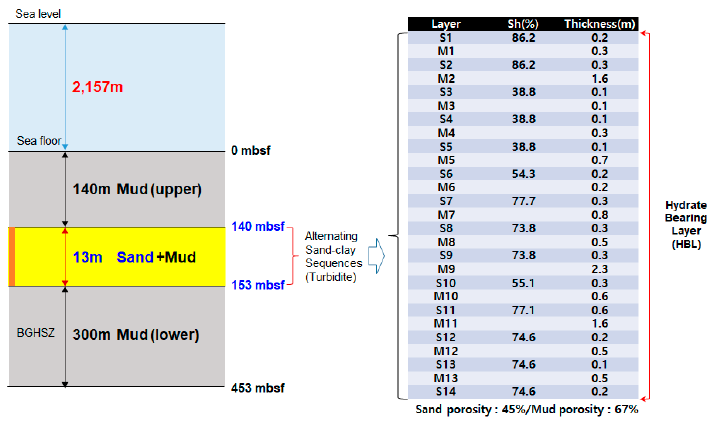
Figure 4. Cylindrical model used in the simulation.